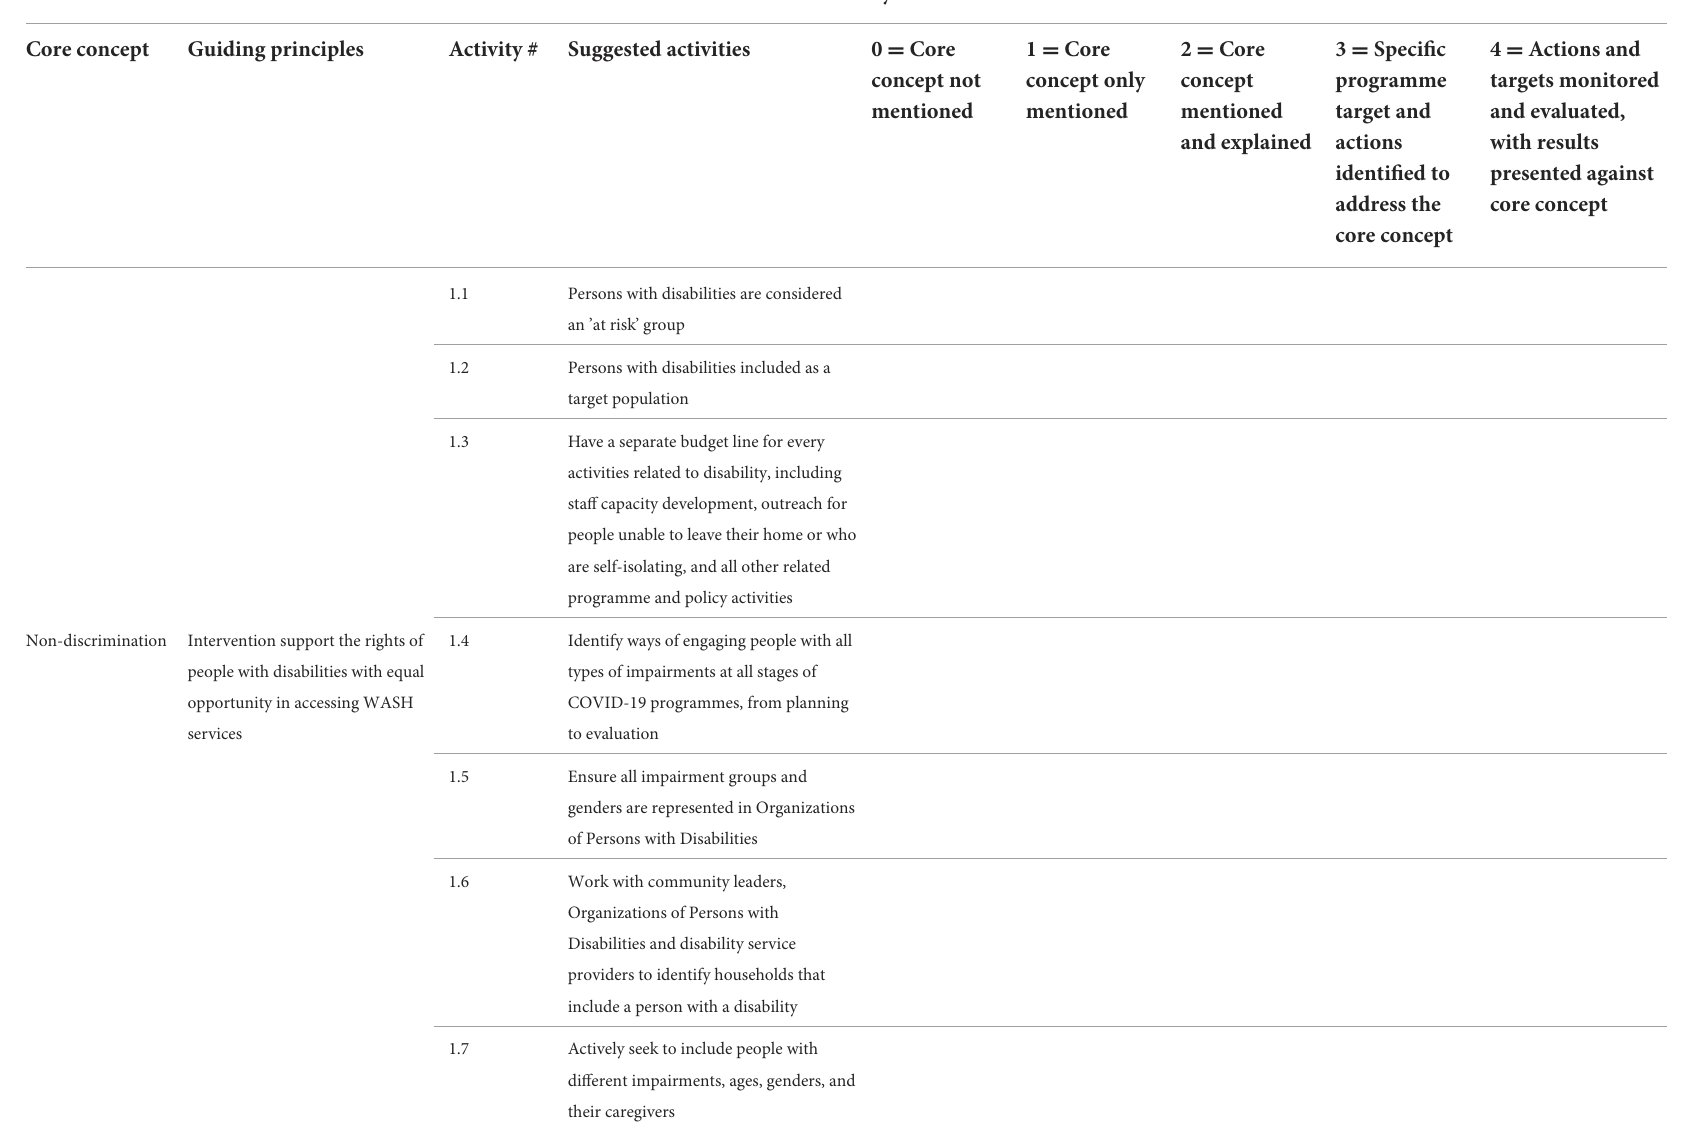
TABLE 1 Example of core-concept non-discrimination, against disability, from the COVID-19 Inclusive WASH